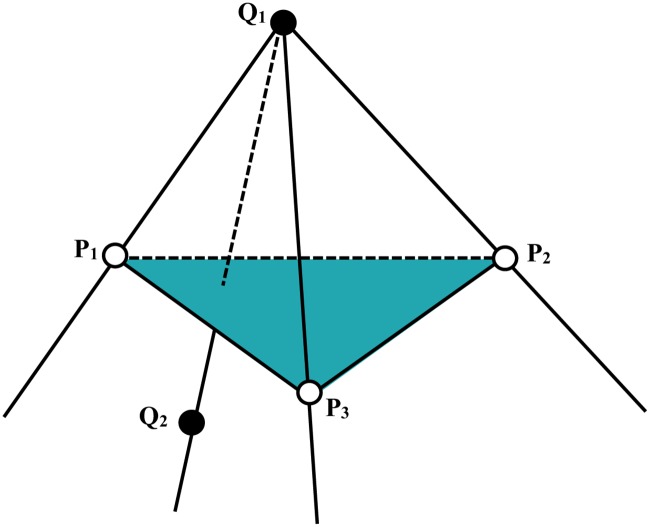
Diagram of an edge intersects with a triangle.